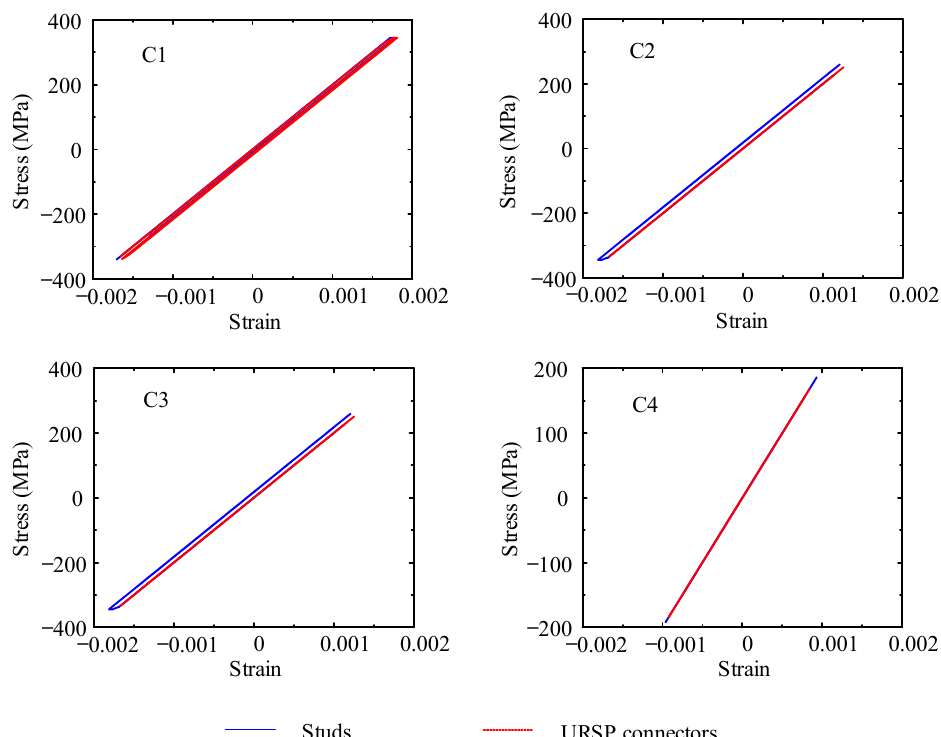
Figure 15. Stress–strain curves of steel of the beam section of the 1st floor.